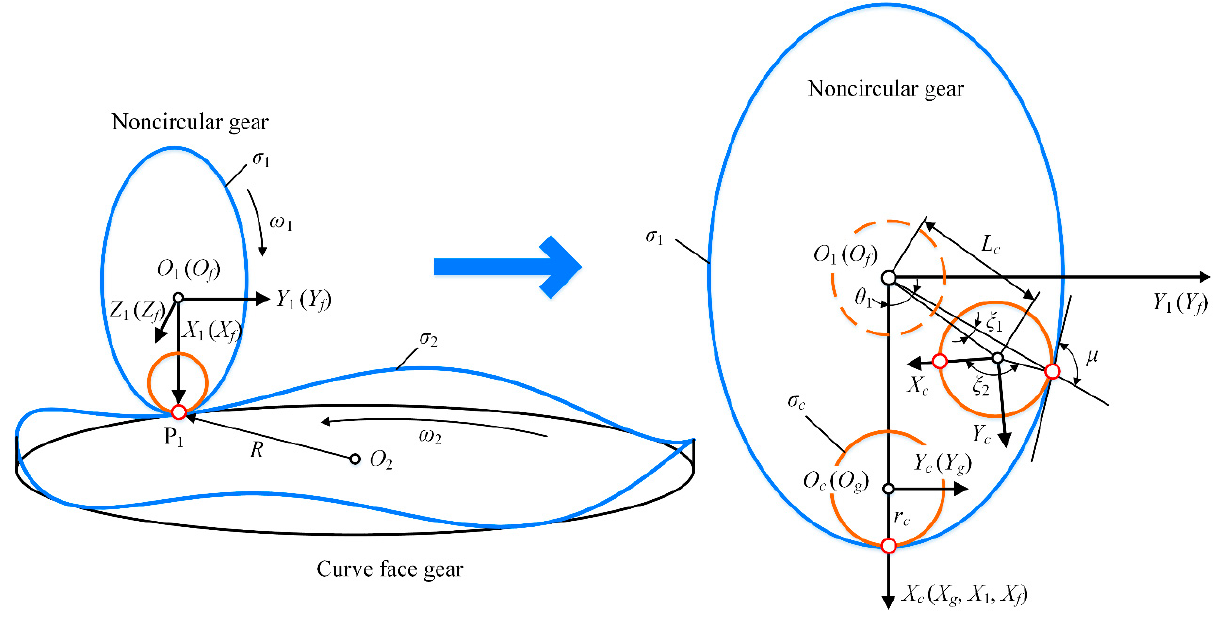
Figure 14 is the generating process from the generating gear to the curve face gear pair. σ c , σ 1 , and σ 2 are the pitch curve of the generating gear, noncircular gear, and curve face gear, respectively. When σ 1 is purely rolling around σ 2 , σ c is purely rolling inside σ 1 . According to the relative motion relationship between σ 1 and σ 2 , the relative motion relationship between σ c and σ 2 can be obtained.